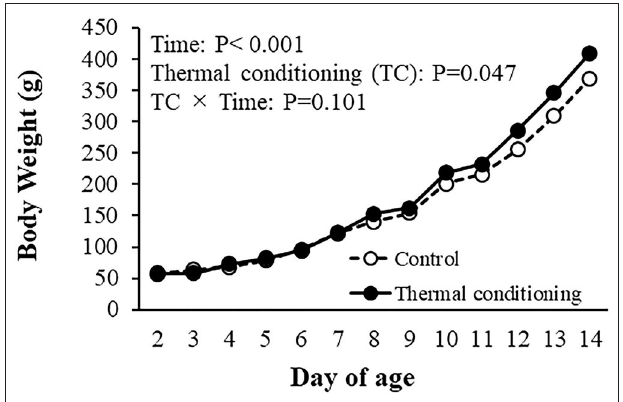
FIGURE 2 | Effect of thermal conditioning on body weight in chicks. Open circles indicate the control group (no-thermal conditioning). Closed circles indicate the thermal conditioning (TC) group. The number of chickens in each group was n = 8.